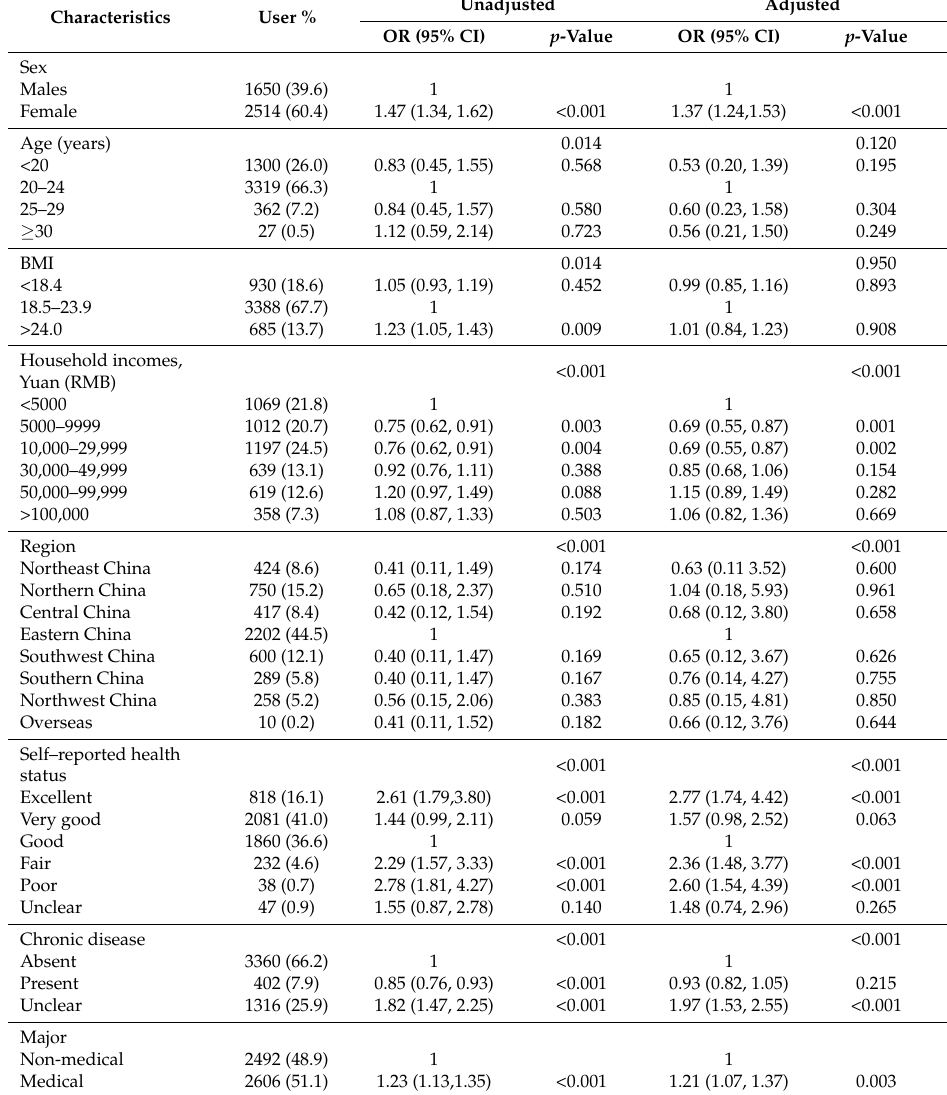
Table 7. Demographic and lifestyle characteristics of study participants using nutritional